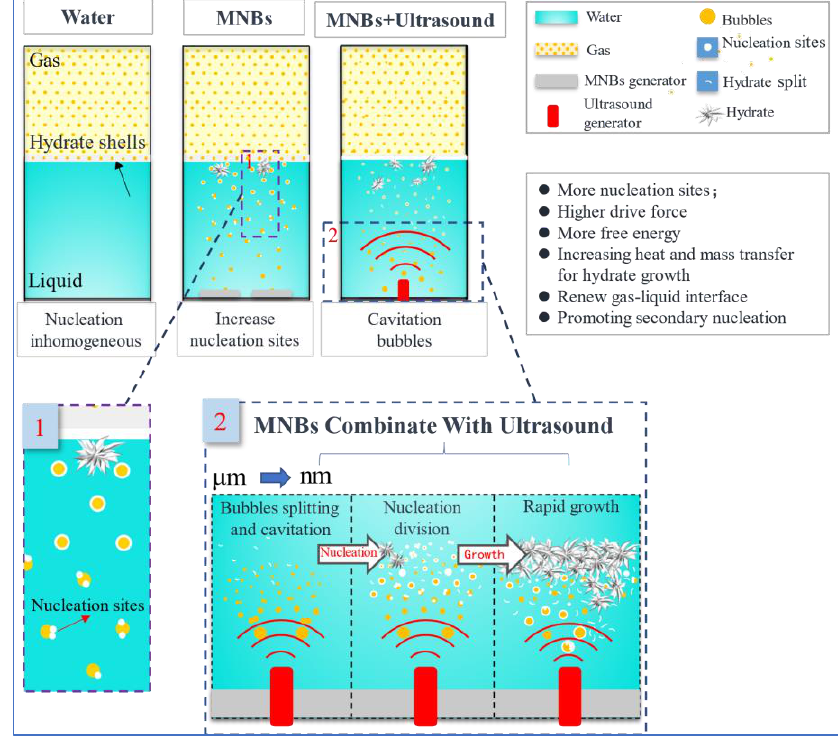
Figure 5. Schematic diagram of the mechanism of MNBs combined with ultrasound-reinforced hy- drate